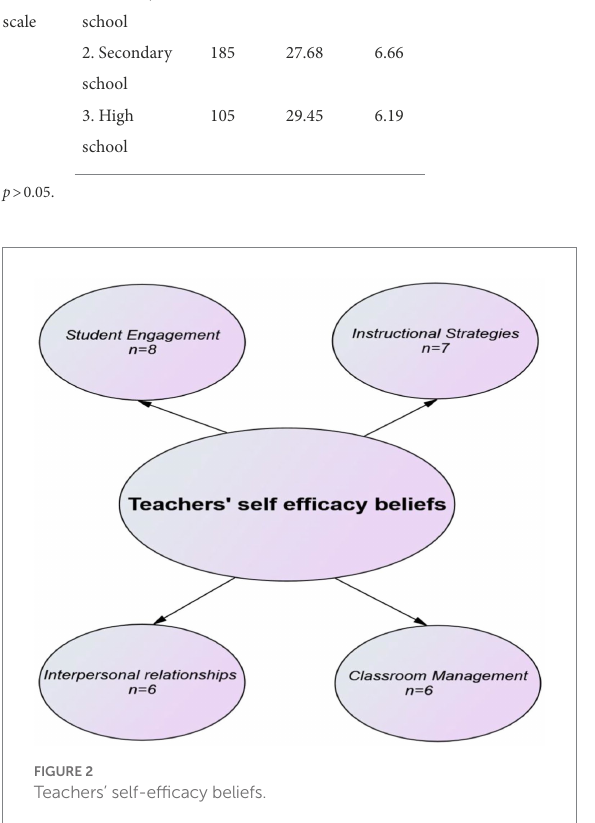
FIGURE 2 Teachers’ self-efficacy